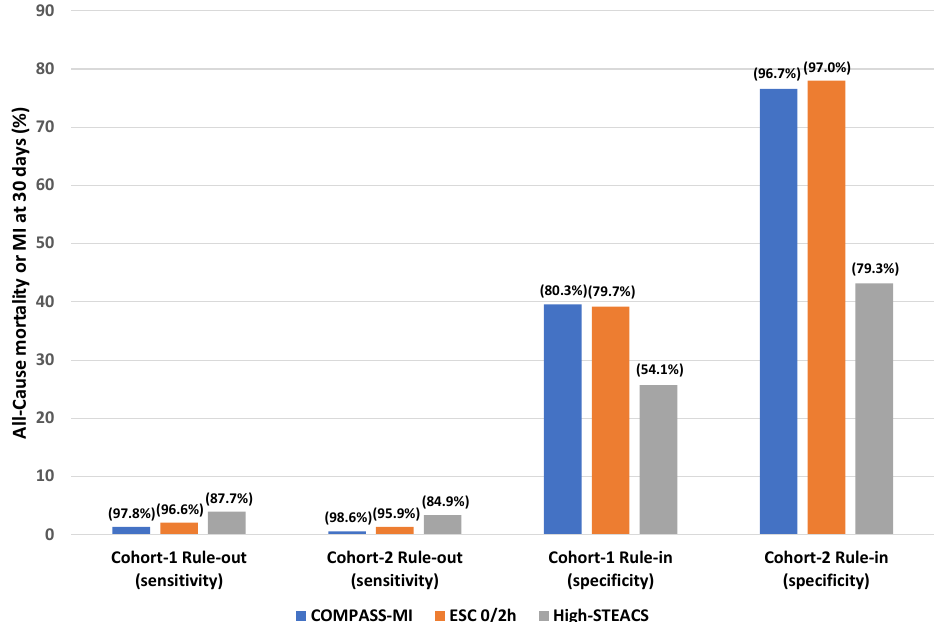
Figure 2. Summary figure of the performance of three different hsTnI algorithms for 30-day all-cause death or MI in undifferentiated ED patients with serial hsTnI measurements (Cohort-1) and ED patients with symptoms suggestive of ACS with serial hsTnI measurements (Cohort-2).